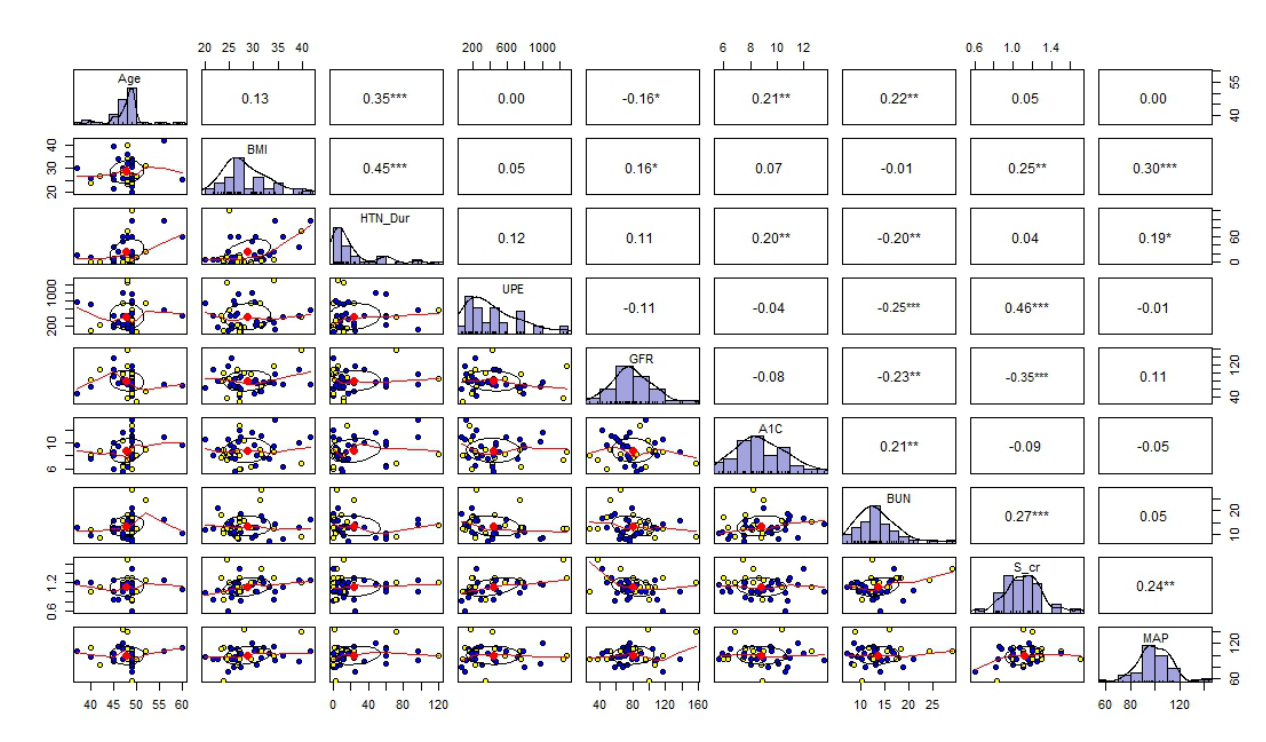
Figure 2. A scatter plot matrix shows the relationship between each pair of predictors. In the diagonal direction, the distri- bution of each predictor is provided. The upper end of the diagonal shows the Pearson correlation between each pair of predictors. Significant codes: ‘***’ 0.001, ‘**’ 0.01 ,‘*’ 0.05. BMI = Body Mass Index; HTN-Dur = Hypertension Duration; UPE = daily Urinary Protein Excretion; GFR = Glomerular Filtration Rate; BUN = Blood Urea Nitrogen; S-cr = Serum Creatinine; MAP = Mean Arterial